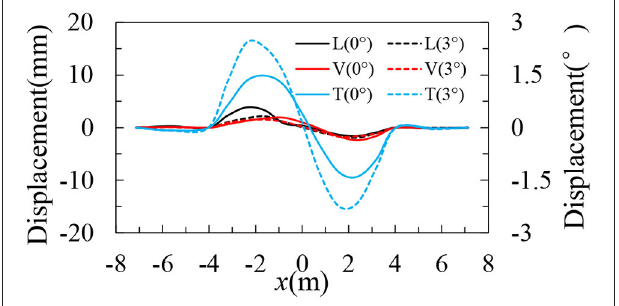
FIGURE 21 | Losing of gravitational stiffness.